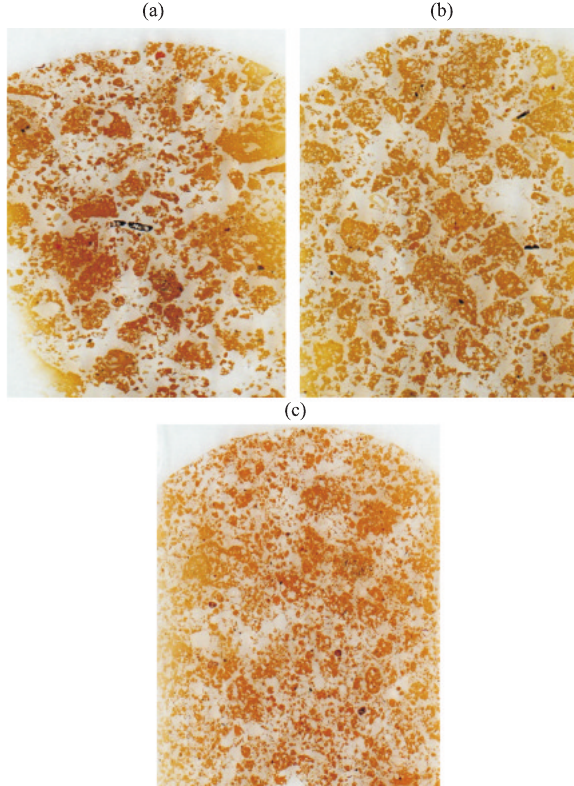
Figura 2. Fotografias das lâminas